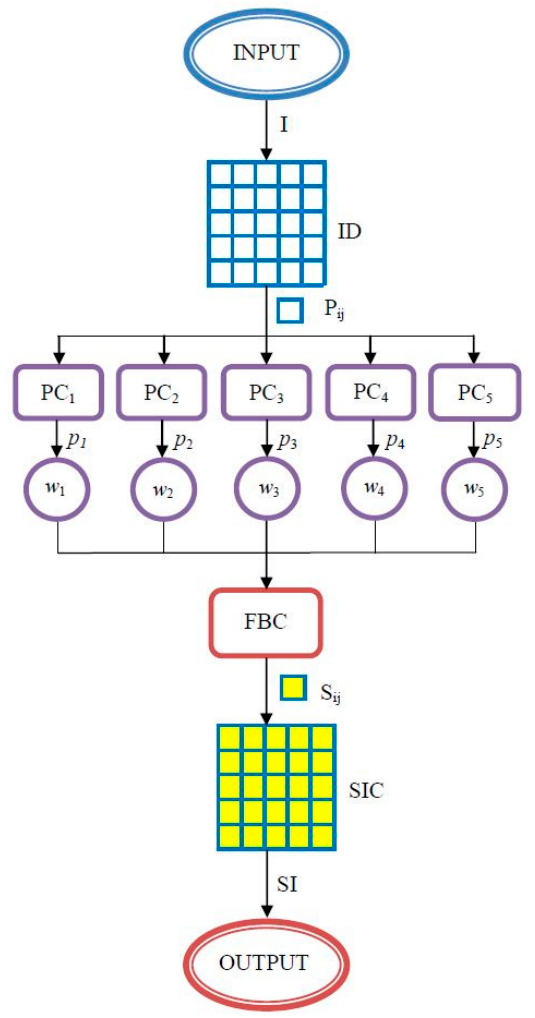
Figure 12. Architecture of the image segmentation proposed system. I—input image, ID—image